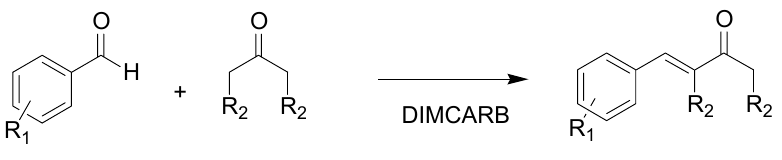
Figure 2. Mannich adduct seen in the reaction